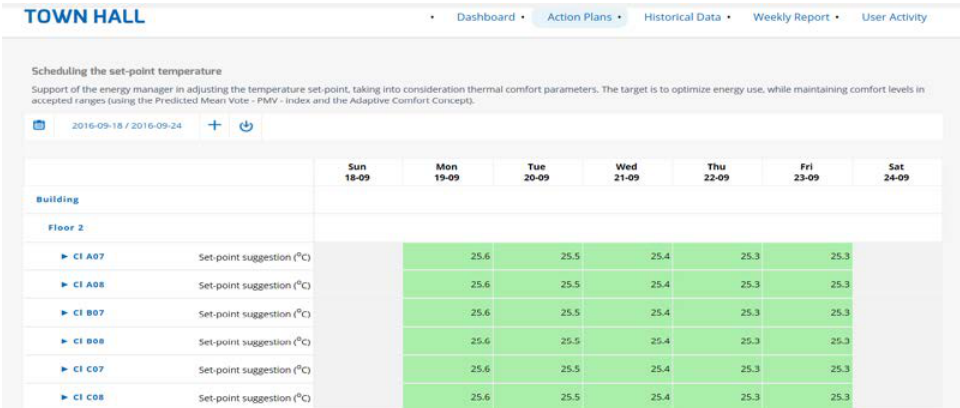
Figure 4. Front-end environments.